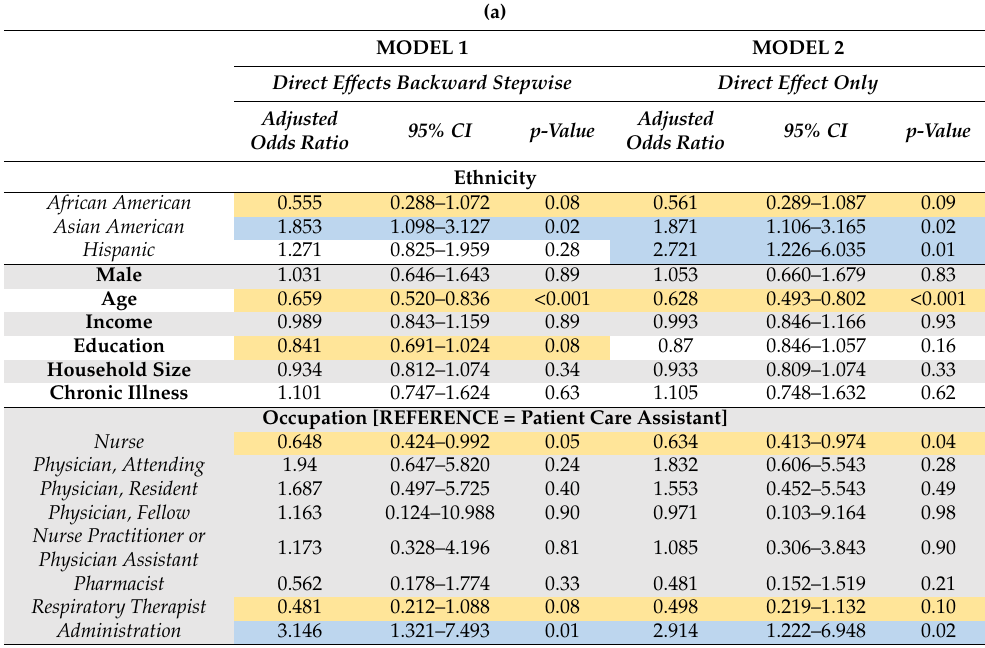
Table 4. ( a ): Predictors of Vaccine Hesitancy using a direct effects model. Odds ratio < 1 indicates group less likely to be vaccinated, while Odds ratio > 1 indicates group more likely to be vaccinated. Significant differences shaded in beige (less likely to be vaccinated) and blue (more likely to vaccinate). ( b ): Predictors of Vaccine Hesitancy using a direct effects model with ethnicity interaction effects. Only interaction effects of Hispanics with clinical area shown as that was the only interaction significant in Model 2. Odds ratio < 1 indicates group less likely to be vaccinated, while Odds ratio > 1 indicates group more likely to be vaccinated. Significant differences shaded in beige (less likely to vaccinate) and blue (more likely to be